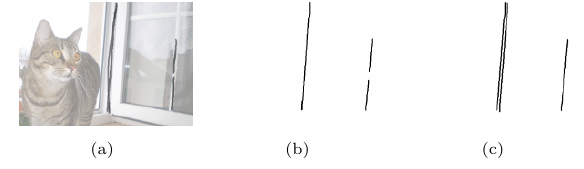
Fig. 6 Temporospatially neighboring strokes. (a) User input with parallel neighboring strokes on the left and contiguous neighboring strokes on the right. (b) Extracted lines without applying E parallel and E contiguous . (c) Extracted lines using E parallel and E contiguous